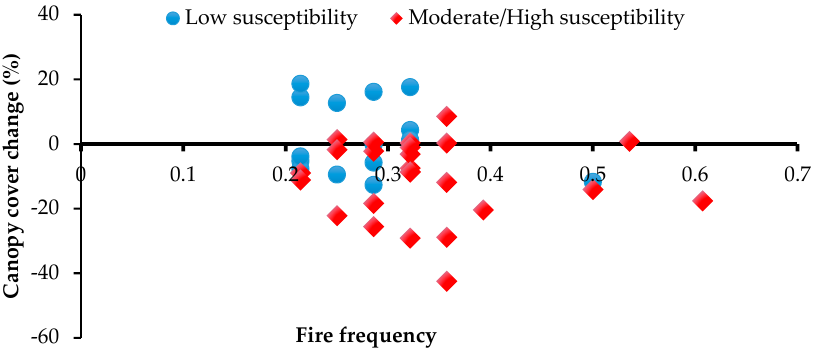
Figure 3. Relationship between fire frequency and canopy cover change (1982/87–2010) at 40 sampled patches, for sites of low vs. moderate/high susceptibility to fire.